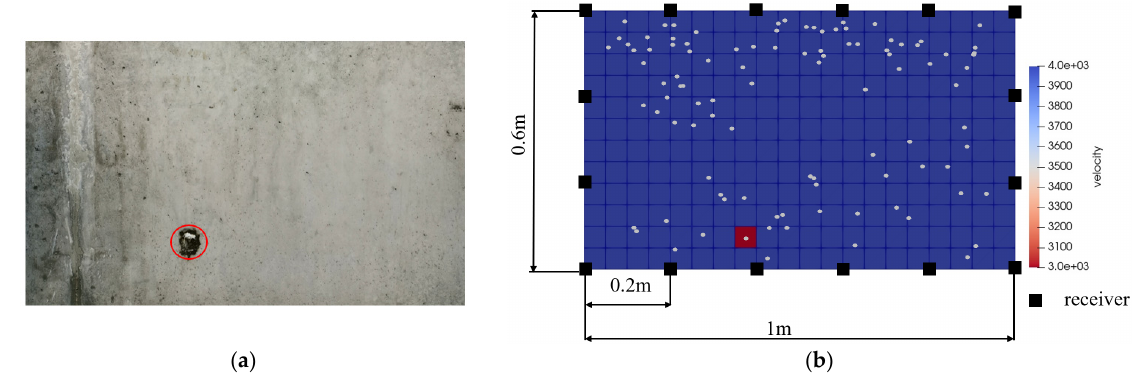
Figure 8. Case 1 of the damage target: ( a ) real damage; ( b ) original distribution. Table 2. Model information for case 1.